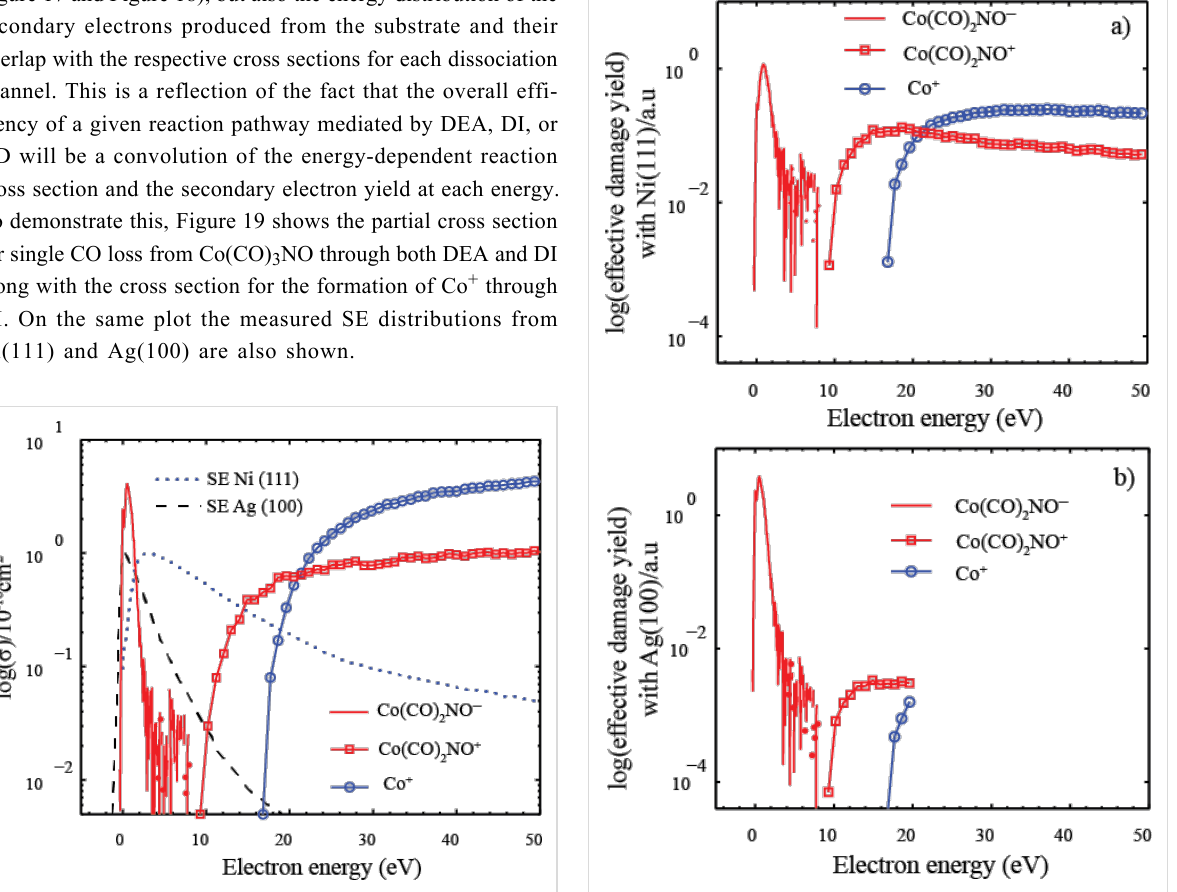
Figure 19: The partial cross sections for single CO loss through DEA (red solid line), for single CO loss through DI (red open squares), and for Co + formation through DI (blue open circles), all adapted from Engmann et al. [10]. Also shown are the measured SE distributions from Ni(111) adapted from Schaefer et al. [6] (blue dotted line) and the measured SE distributions from Ag(100) adapted from Knights et al. [9] (black dashed line).